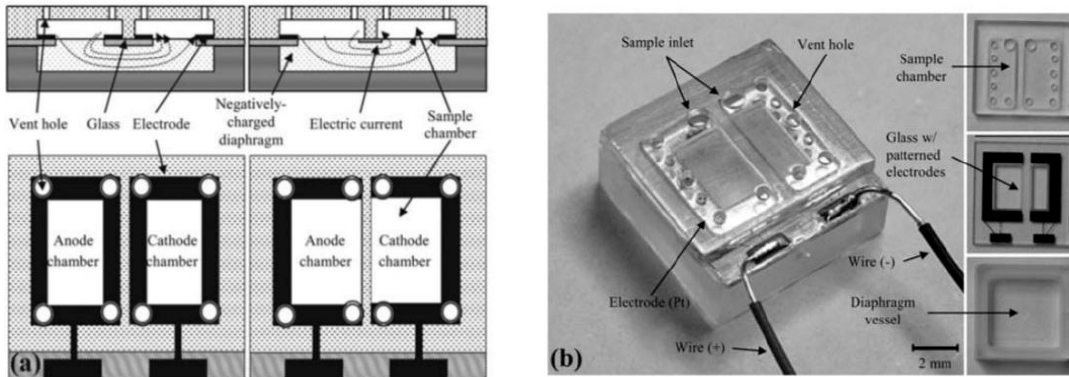
Figure 28. Design of the electrochemical cell lysis devices utilized in [109]. ( a ) Cross-sectional and top-down views of the micro-devices. Cathode and anode chambers were separated by an ion exchangeable polymer diaphragm. ( b ) Photographs of the same microdevice. Adapted with permission from [109]. Copyright 2010 Royal Society of Chemistry.